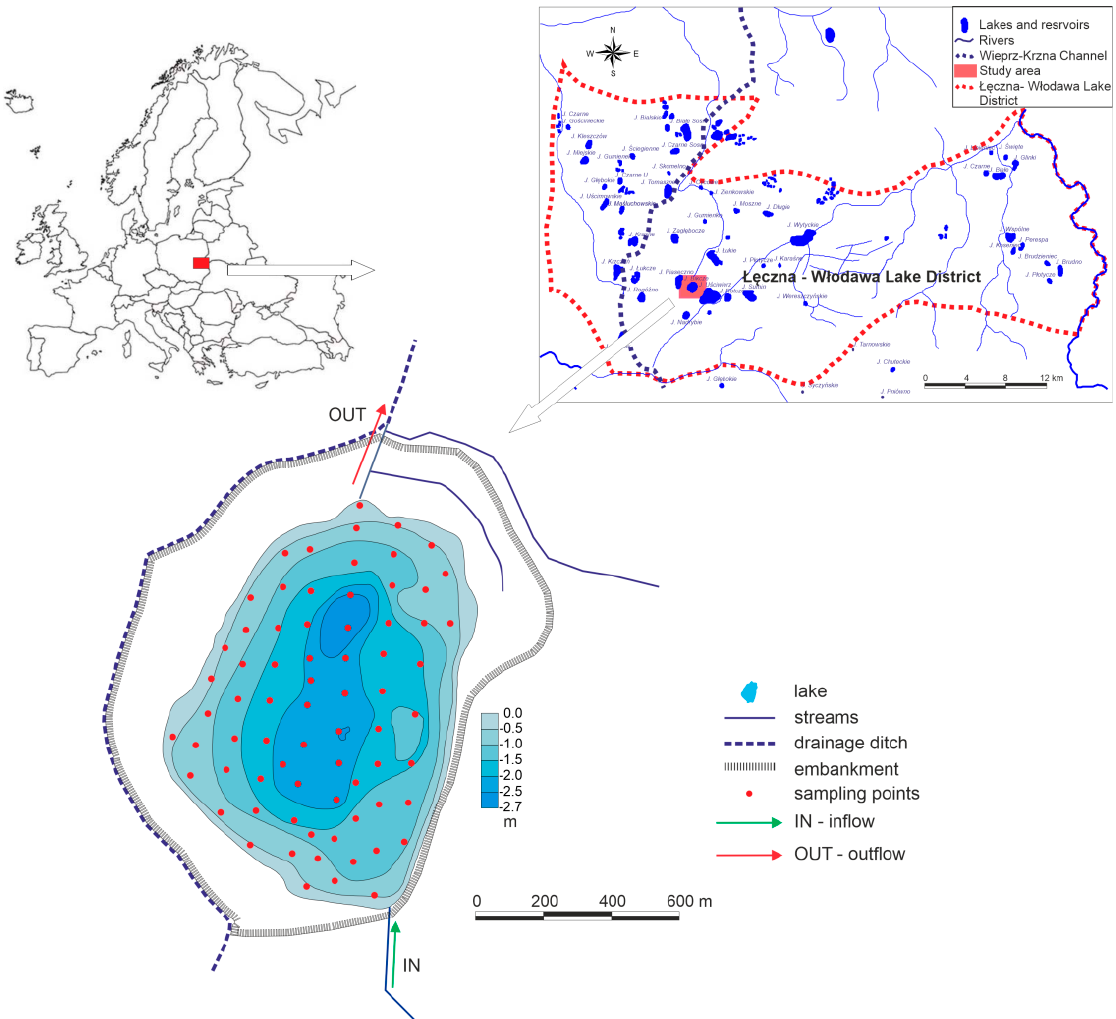
Figure 1. Location and bathymetric map of a study lake.